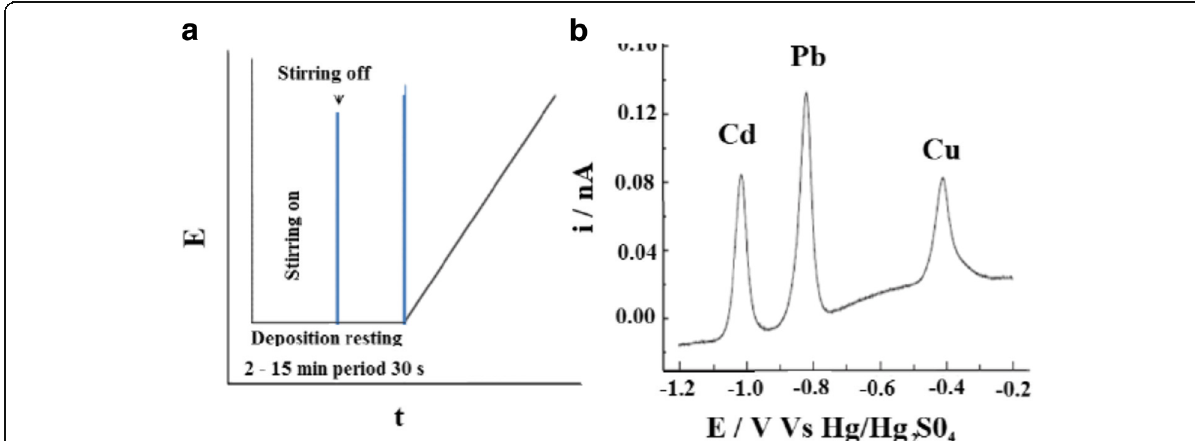
Fig. 11 a Excitation signal. b Response curve of anodic stripping voltammetry. (Reprinted with permission from Reference Baron-Jaimez et al. 2013). © 2013 IOP